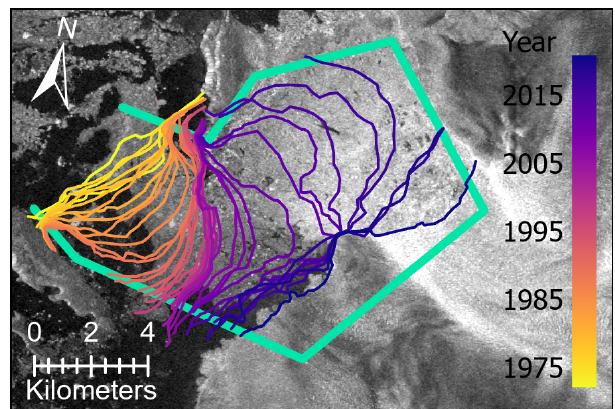
Figure 3. Illustration of terminus traces and box method for Kjer Gletsjer (no. 42). Each trace intersects the glacier’s box (green) to form a closed polygon. The areas of sequential polygons are differ- enced to create a time series of glacier area change. The basemap is a Sentinel-1 SAR mosaic from 4–9 February